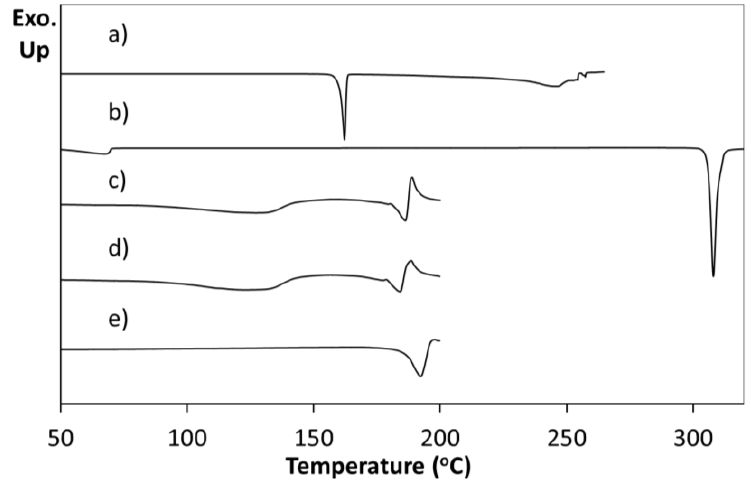
Figure 7. Differential scanning calorimetry of ( a ) 4Cl35DNBA and ( b ) cytosine, together with those for products of the evaporative crystallisation of cytosine and 4ClDNBA in: ( c ) a 2:1 starting material ratio in ethanol and water (1:1 by volume); ( d ) a 2:1 starting material ratio in acetone and water (1:1 by volume); ( e ) a 1:1 starting material ratio in acetone and water (1:1 by